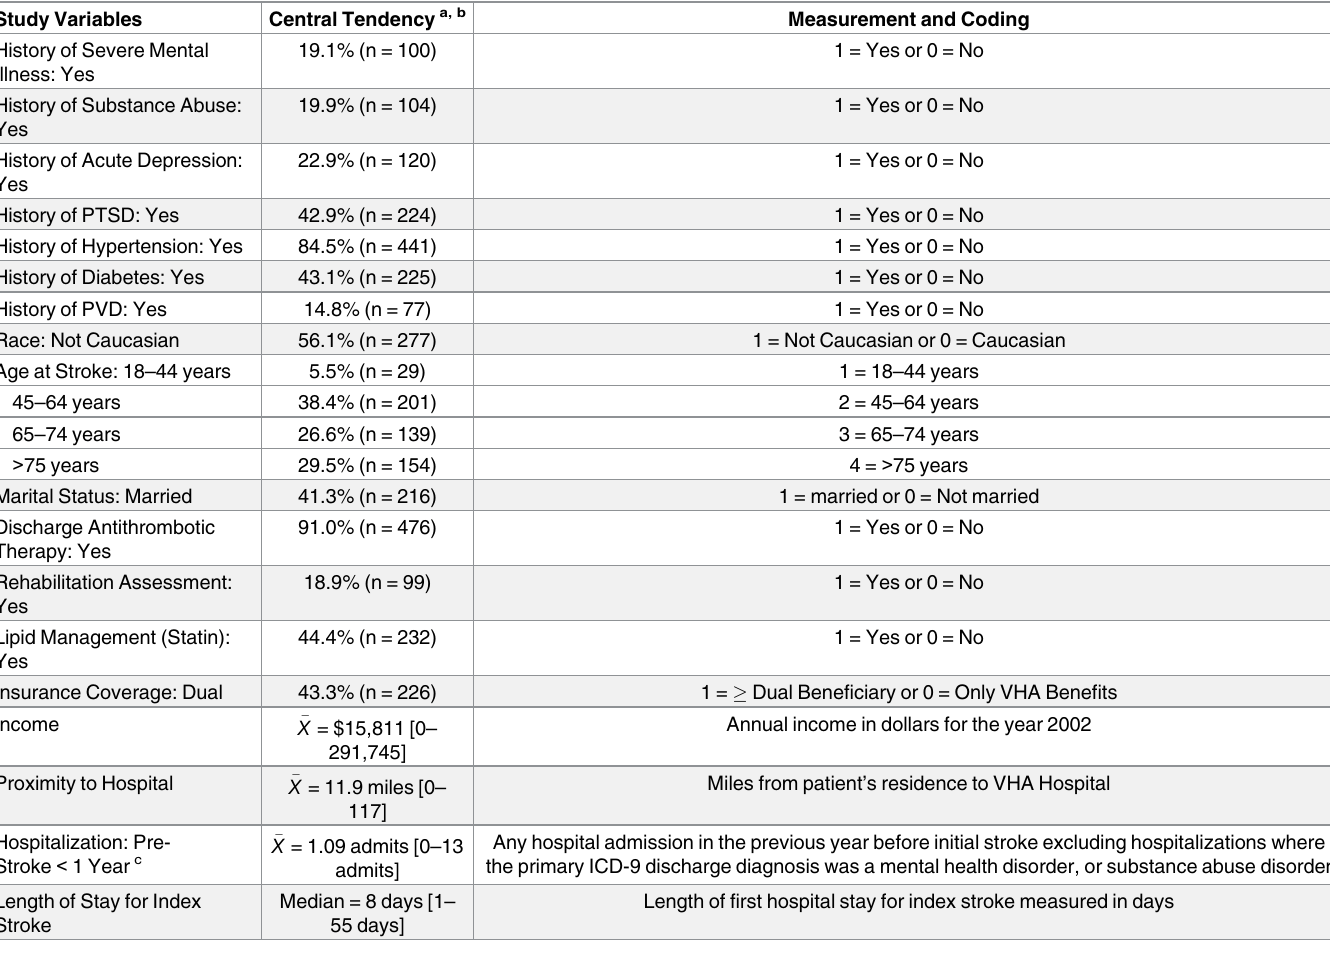
Table 1. Description Independent Variables in the study population (N = 523). Study